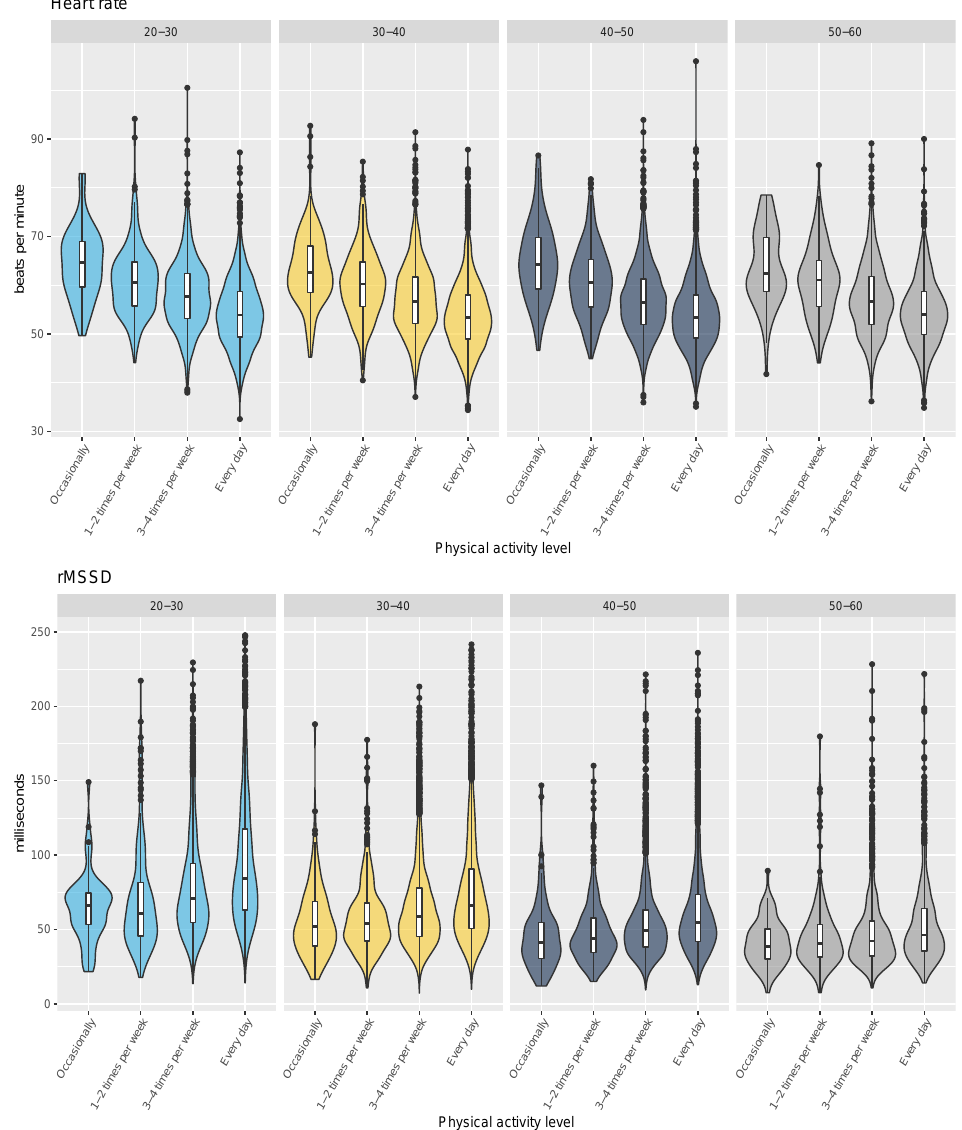
Figure 8. Relationship between resting heart rate, rMSSD, and both age and physical activity level. The association between heart rate and physical activity level remains strong across all age groups, while for rMSSD, it becomes weak for older